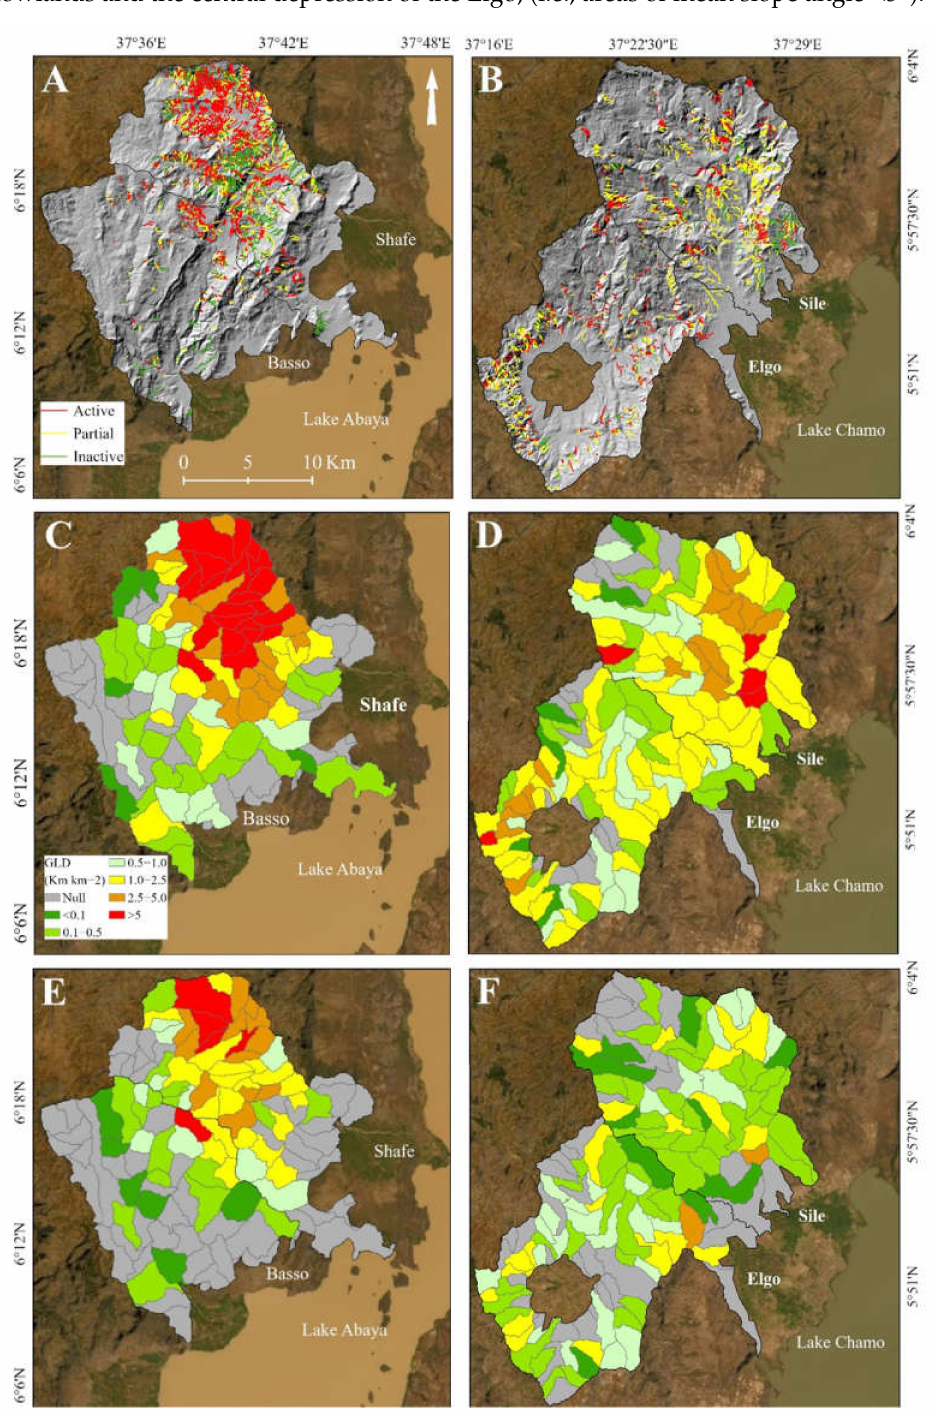
Figure 2. Gully inventory ( A , B ) and the corresponding GLD for all ( C , D ) and only active ( E , F ) gullies. The densities are represented at the level of the sub-catchments. The hillshade in ( A , B ) is from the 30 m SRTM DEM [68]. Background imagery is from Google Earth (15 June